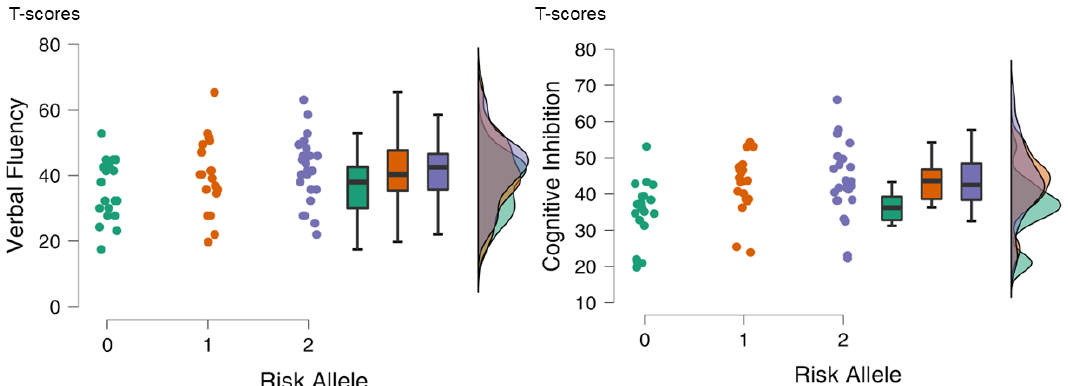
Figure 4. Relations of risk genotype defined as the number of the risk allele TGT (Risk Allele) with cognitive phenotypes in patients. For each genotype, the scatterplot, boxplot (mean, SD), and density are shown.